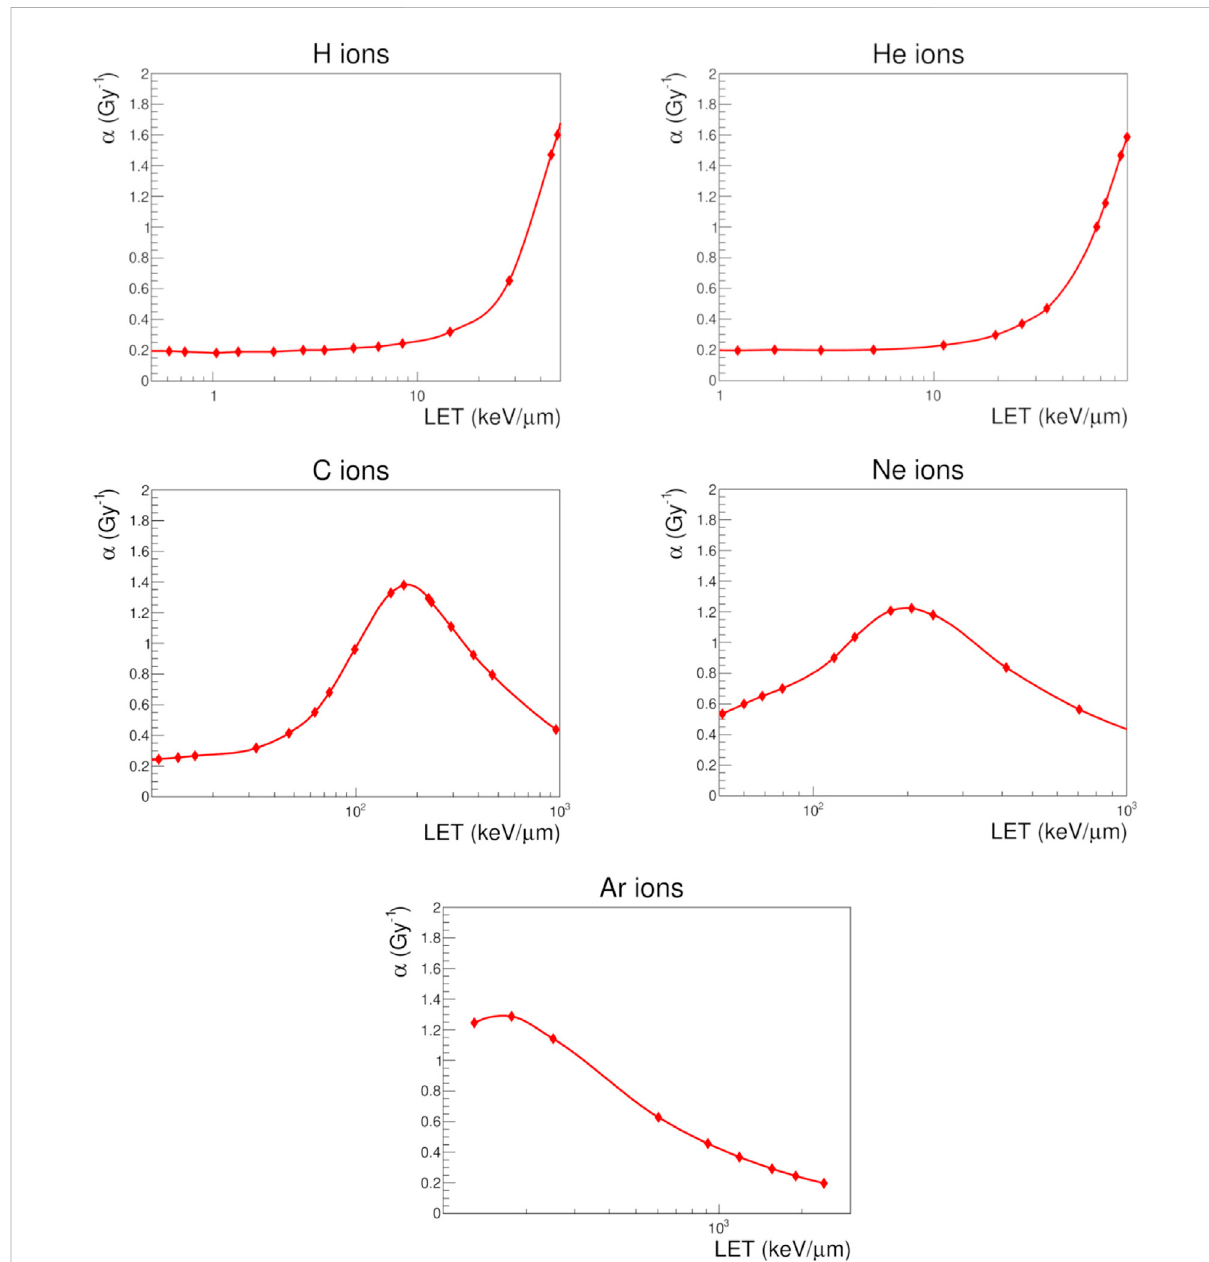
FIGURE 7 Linear parameter α obtained with NanOx ( fi lled symbols) for V79 cells in response to hydrogen, helium, carbon, neon and argon ions in the experimentally-accessible LET range. The solid curves that connect the calculated values are for visualization purposes